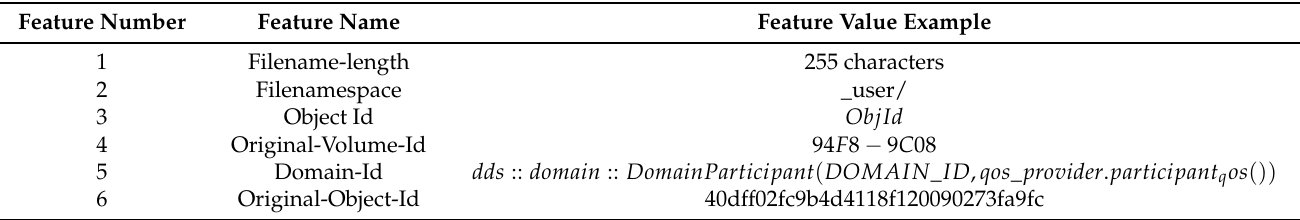
Table 2. The features in a